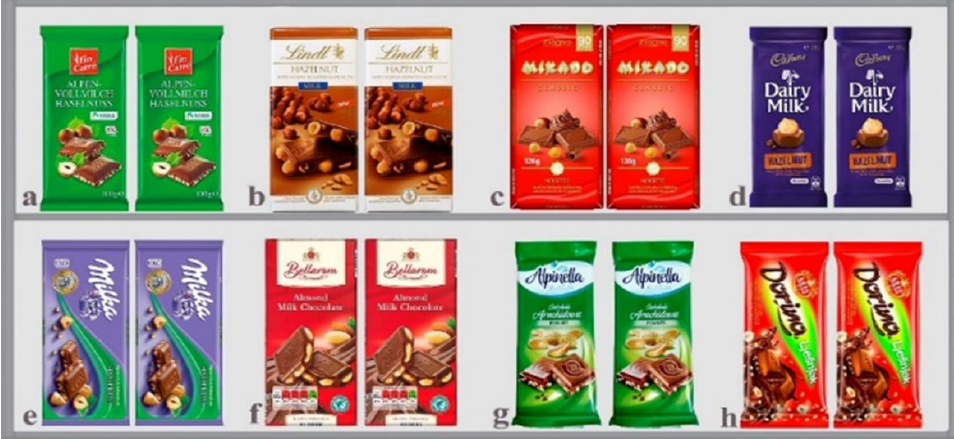
Figure 1. Template for product evaluation (chocolate): ( a ) Fin Carre, ( b ) Lindt, ( c ) Zveˇcevo Mikado, ( d ) Dairy Milk, ( e ) Milka, ( f ) Bellar, ( g ) Alpinella, ( h ) Kraš Dorina.